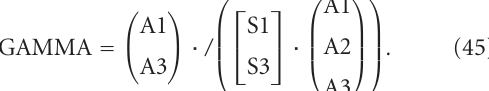
Figure 25: The printed Yagi-Uda antenna is made of 15 dipoles printed on a FR4 substrate.